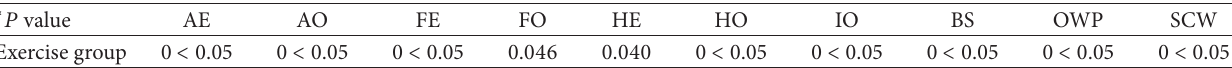
Table 4: The result of paired 𝑡 -test in exercise group in body-image subscales.